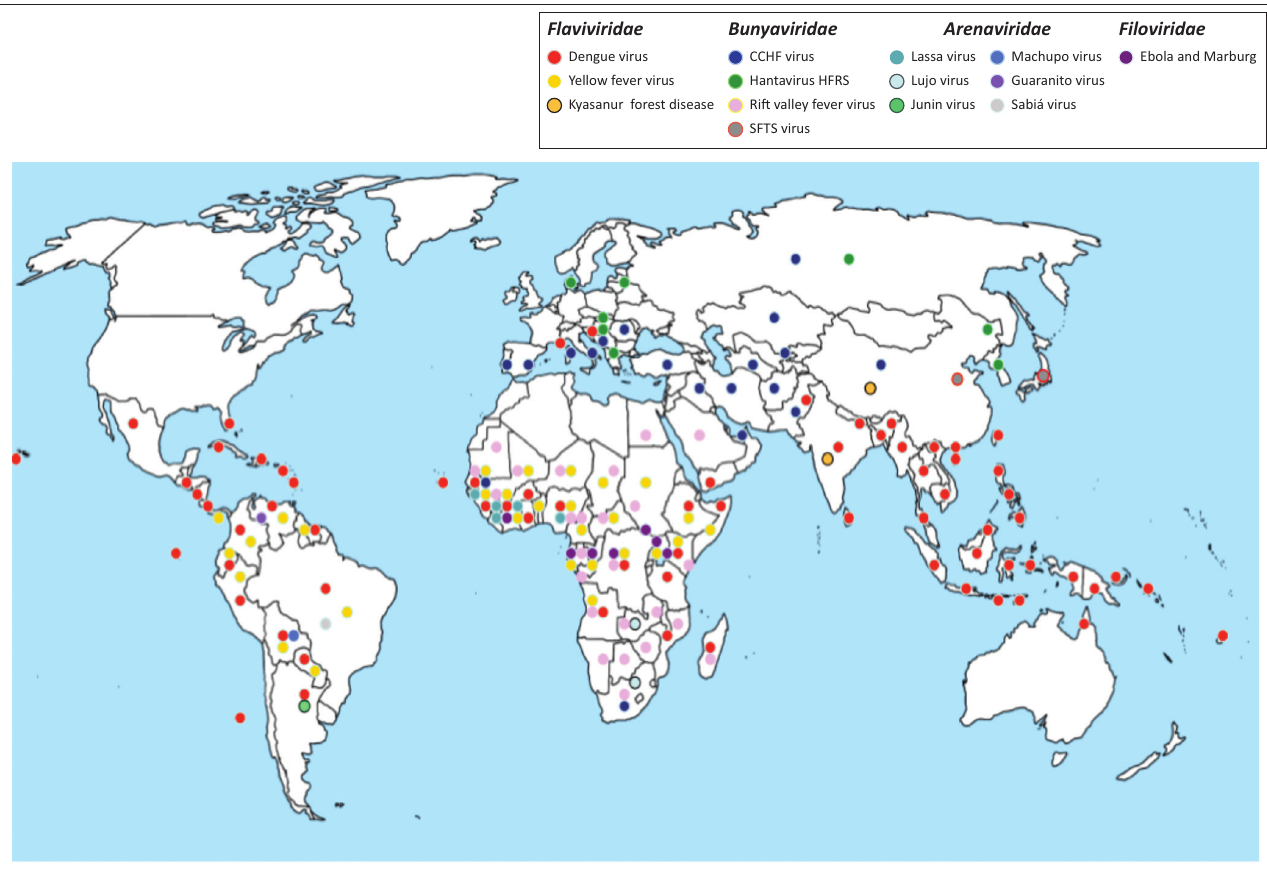
FIGURE 1: Geographical distribution of Viral haemorrhagic fevers